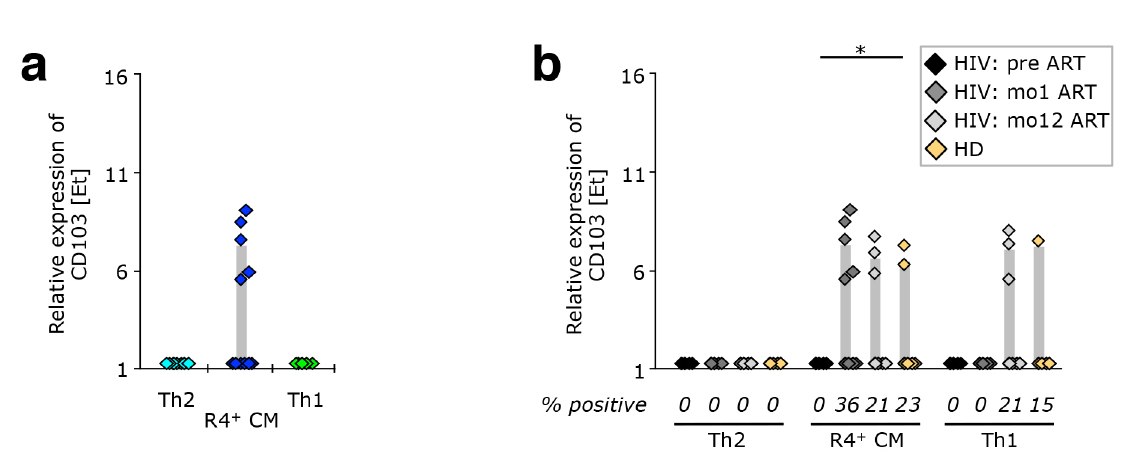
Figure 6. CCR4 + T appear to be released from peripheral tissue sites upon ART initiation. PBMC from CM healthy donors, as well as cells isolated before or after 1 or 12 months of ART from HIV-1-infected adults were stained with the “sorting” panel (Supplementary Table 1). Subsets of CD4+ T cells were sorted as indicated in Supplementary Figure 4 and their gene expression profiles determined by multi-parametric quantitative RT-PCR. (A) CD103 expression on Th -like, CCR4 + T , and Th -like cells isolated after 1 2 CM 1 month of antiretroviral therapy. (B) Expression of CD103 in CCR4 + T , Th -, and Th -like cells from CM 2 1 healthy donor PBMC (n = 9), and longitudinal samples from HIV-1 patients (n = 12). Bar graphs show interquartile ranges, median bars, as well as individual data points. Statistically significant differences are indicated: * P < 0.01, ** P < 0.001, *** P <